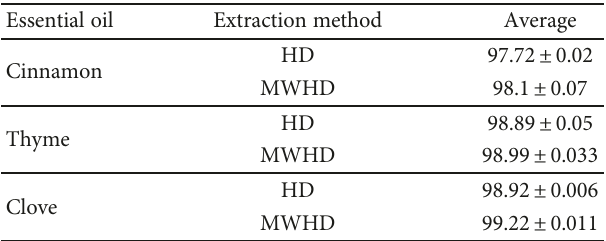
Figure 6: Graphical representation of emulsi fi cation percentages of all starches. Table 4: E ffi ciency of the encapsulation process of di ff erent essential